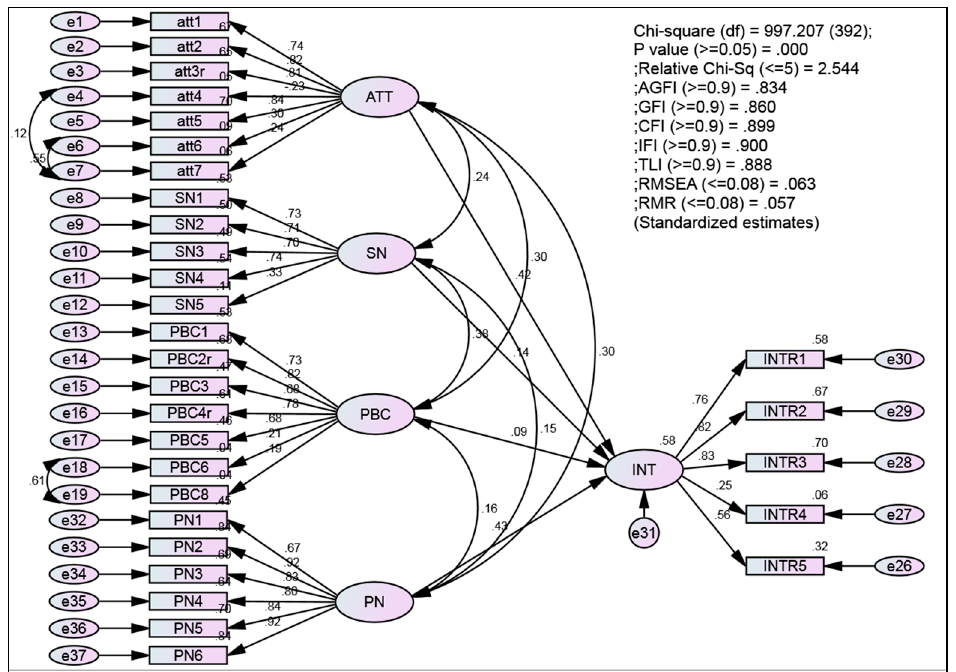
Figure 6. Structural model showing the level of prediction of recycling intention by TPB components and personal norms. Note: ATT: Attitude (seven items); SN: Subjective norms (five items); PBC: Perceived behavioral control (seven items); PNs: Personal norms (six items); INT: Intention (five items).